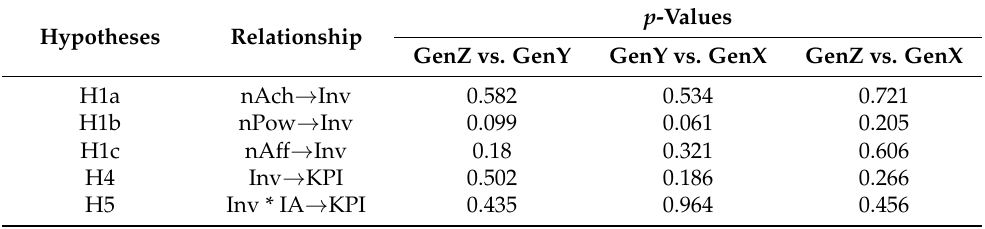
Table 11. Assessment of group difference for